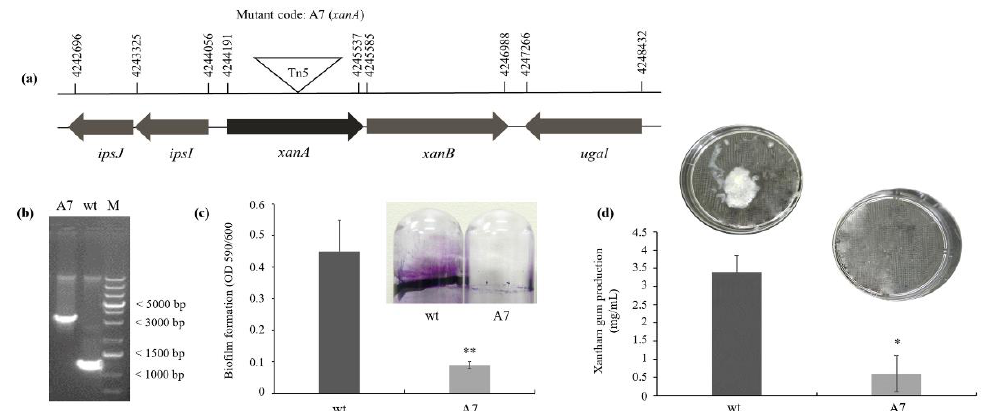
Figure 1. Identification of the A7 mutant from an EZ-Tn5 library of X. citri by biofilm and xanthan gum assays. ( a ) Genetic organization of the xanA gene in the X. citri subsp. citri strain 306 genome and the lengths of the open reading and transposon insertion site in the xanA mutant are indicated. The length of each arrow represents the relative open reading frame (ORF) size and indicates the direction of transcription. The triangle indicates the Tn5 insertion site. The annotation information and sizes of the genes were obtained from the genome sequence database of X. citri strain 306 (National Center for Biotechnology Information, NCBI, accession No: AE008923). ( b ) PCR analysis confirmed the insertion of EZ-Tn5 in the xanA gene (XAC_RS18095 or XAC3579). DNA was amplified using the primers XAC3579F and XAC3579R targeting a 500-bp region surrounding xanA from the wild-type (wt) and A7 ( xanA ::Tn5) strains, demonstrating the increase in the length of the obtained PCR amplicon by insertion of EZ-Tn5 transposon (1.22 kb) generating a PCR product with 2.22 kb in A7 mutant. M: Thermo Scientific O’GeneRuler 1 kb Plus DNA Ladder. ( c ) Biofilm formation on the abiotic surface by the wt and A7 mutant strains. The values were normalized to bacterial growth (OD at 600 nm). Values are expressed as the means ± standard deviations of six biological replicates. ( d ) Xanthan gum production. Values are expressed as the means ± standard deviations of three biological replicates. * indicates significant difference by t-test ( p < 0.05) compared with